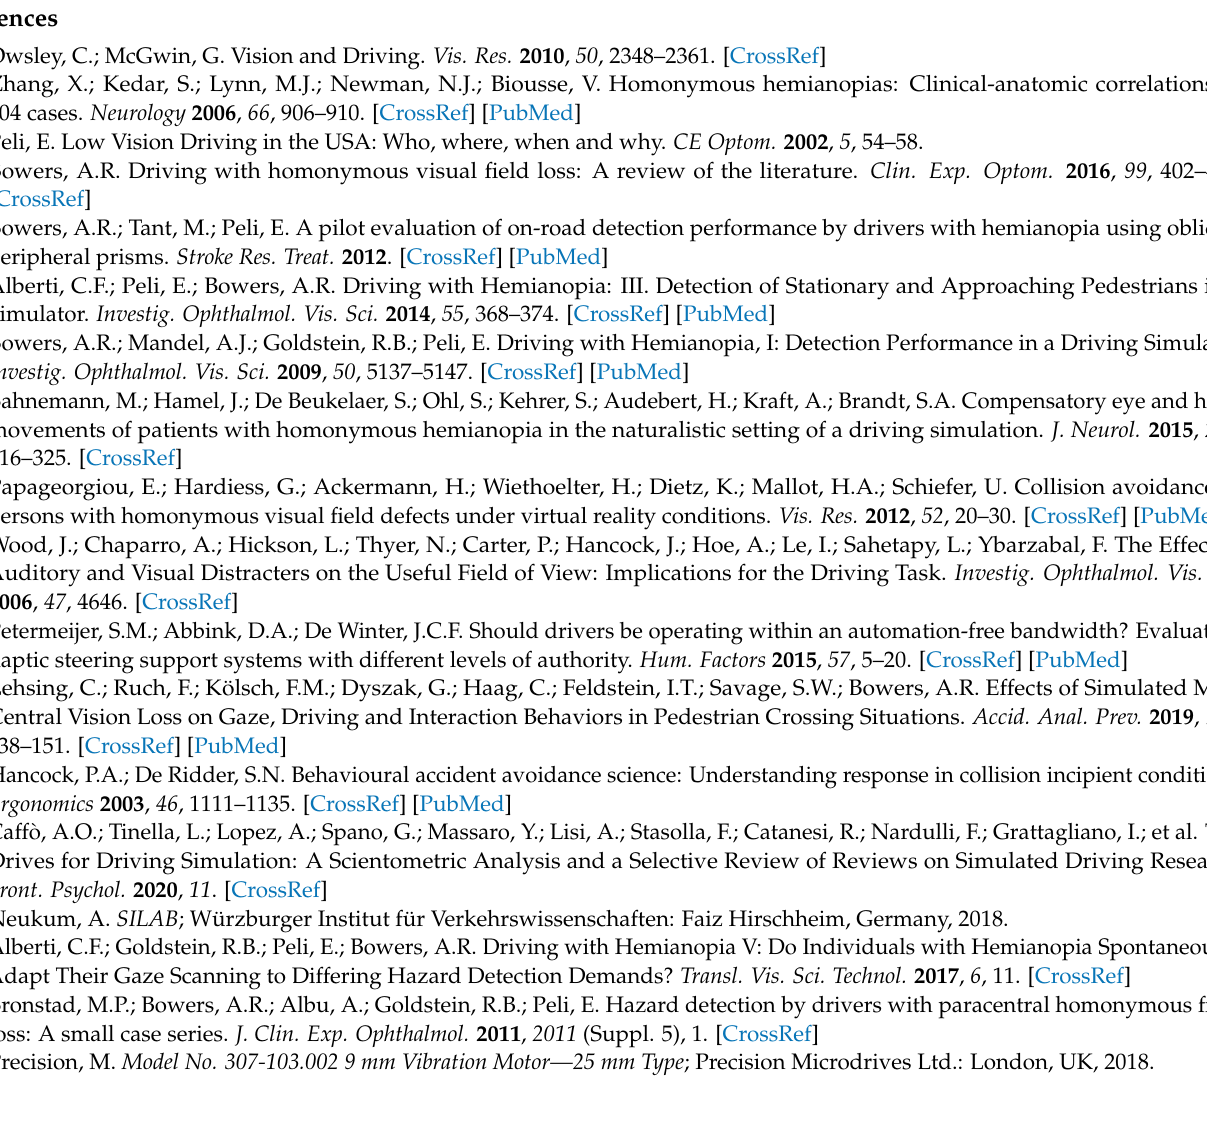
Figure A3. Data for a participant with a left HVFD for an event in which a human-controlled pedestrian (HCped) crosses from the left (blind) side of the participant in a drive when the ADAS was not engaged. For most of the interaction phase, the pedestrian is in the blind hemifield, and the participant did not see the pedestrian make a head turn and indicate the intention to cross. The participant made a late fixation on the HCped, almost at the end of the interaction phase but did not slow down. The human operator thought that it was not safe to cross so the HCped did not cross the road. The situation was categorized as unsafe.